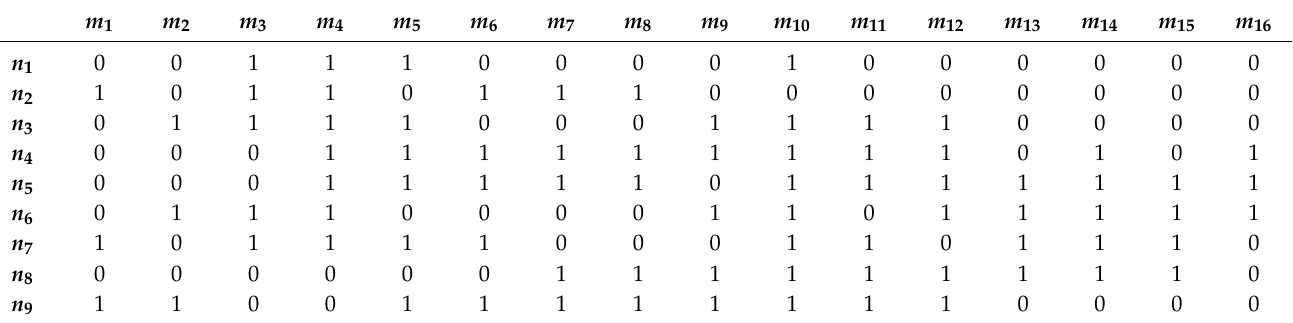
Table 10. Transport travel matrix for Variant #1.